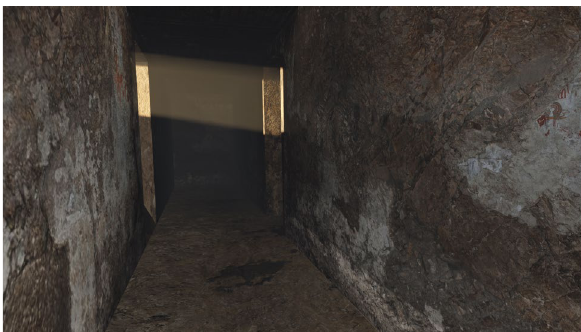
Figure 17 . View from the pillars’ hall with all doors closed.